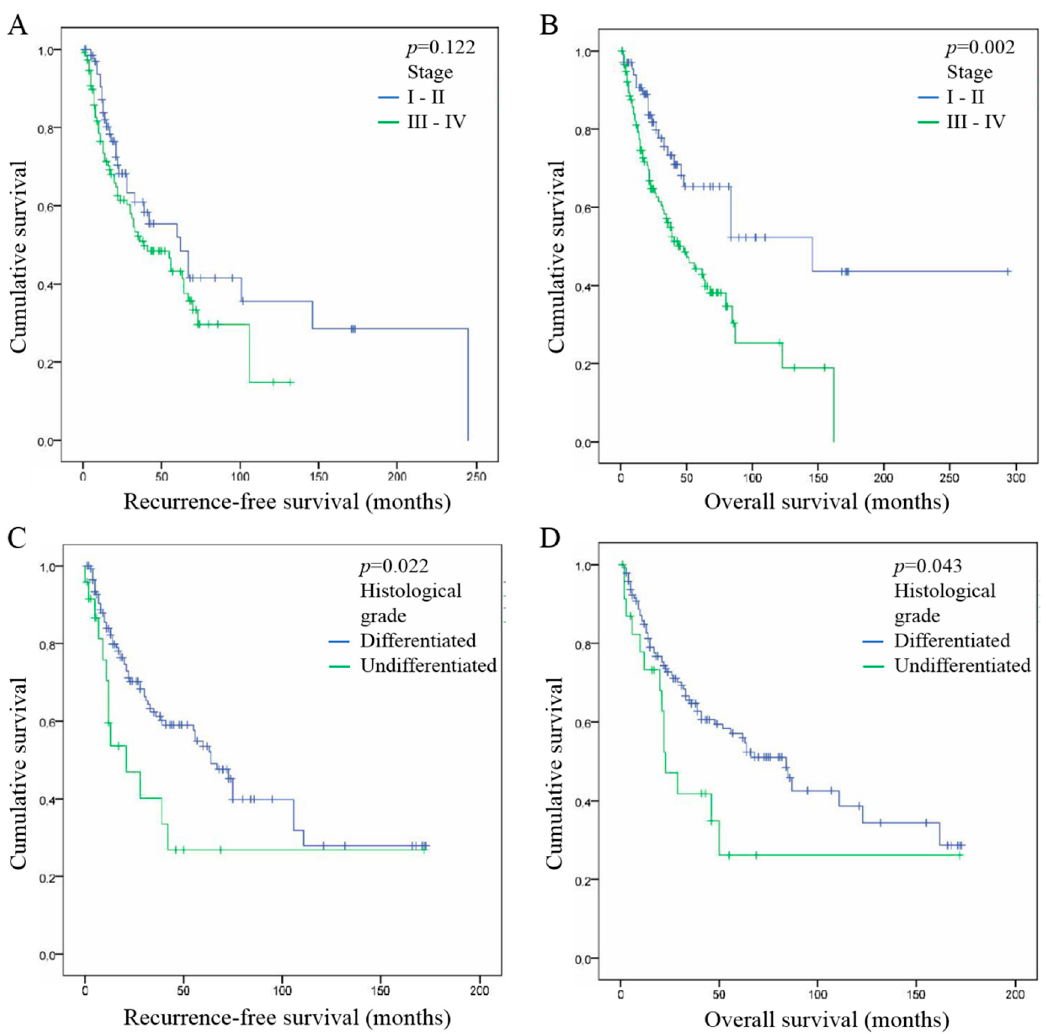
Figure 3. Association between tumor clinical characteristics and prognosis in HNSCC. ( A ) Association between tumor stage and recurrence-free survival (RFS) of patients. ( B ) Association between tumor stage and overall survival (OS) of patients. ( C ) Association between tumor histological grade and RFS of patients. ( D ) Association between tumor histological grade and OS of patients. 2.6. FoxP3+ Treg Infiltration, Tumor Stage and Histological Grade are Independent Prognostic Factor of